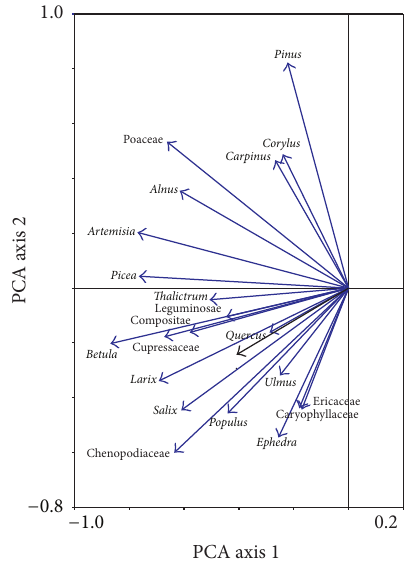
Figure5:PCAresultsforprincipalpollenfromtheBeihongSection.